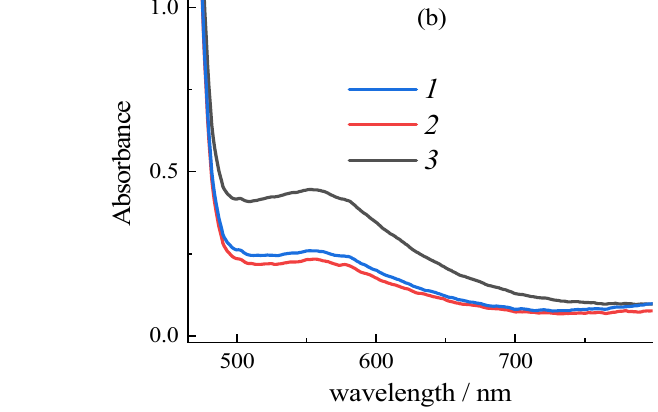
Figure 5. ( a ) UV-vis spectra of 200 mg/mL of as-prepared individual FC in various buffer solutions. ( b ) UV-vis spectra of 200 mg/mL of FC after heating of buffer solutions at 55 °C for 4 days (modeling of storage at 20 °C for 96 days). Note: 1—citrate buffer, pH 6, 2—phosphate buffer, pH 7.4, 3—acetate buffer, pH 5.5.